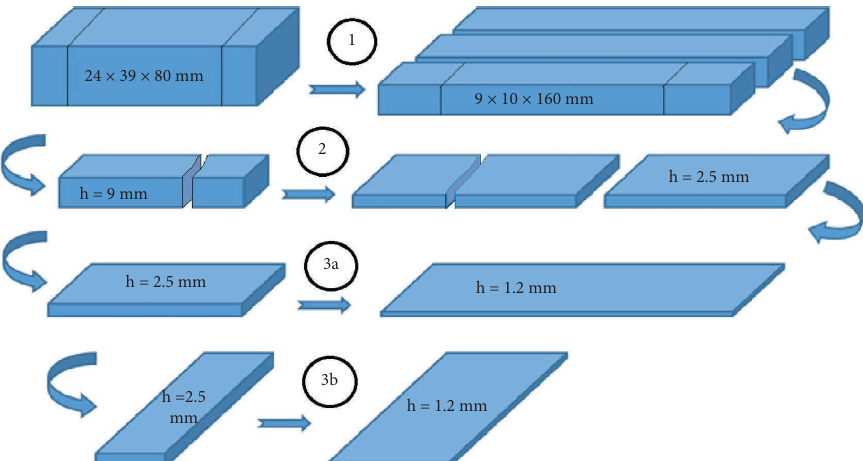
Figure 2: Te scheme of the stages of rolling samples after TE: stages 1, 2, 3a indicate lengthwise rolling and 3b indicates cross